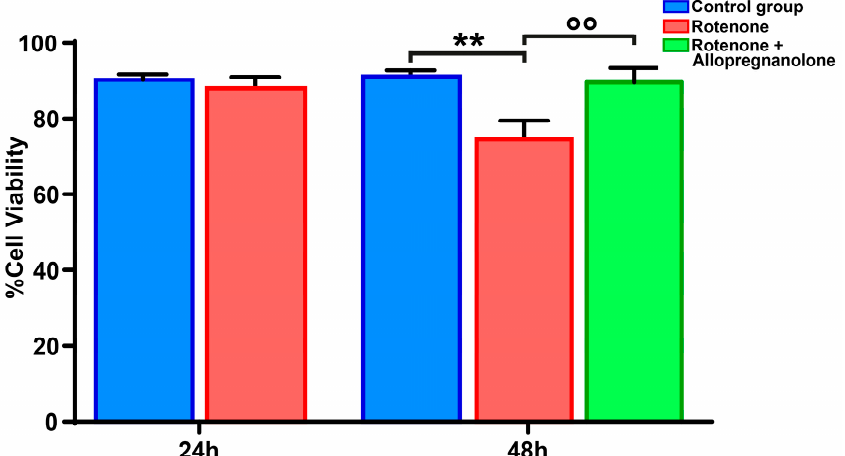
Figure 5. Viability of HMC3 cells exposed to rotenone (100 nM) at di ff erent time intervals (24 h and 48 h) and rescued by allopregnanolone (1 nM). The data represent the average ± SEM of two inde- pendent experiments. ** p < 0.01 rotenone vs. control group; °° p < 0.01 rotenone + allopregnanolone vs. rotenone, according to one-way analysis of variance (ANOVA) followed by Holm–Šídák post hoc test for multiple